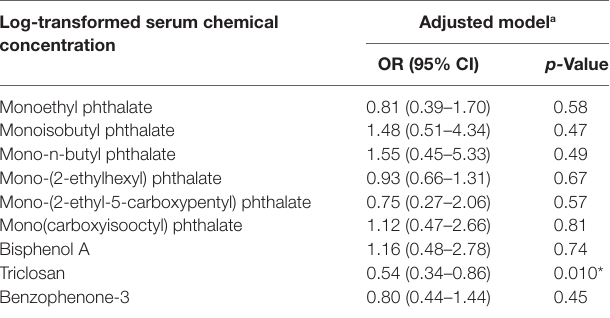
Table 2 | Characteristics of the study population. characteristics